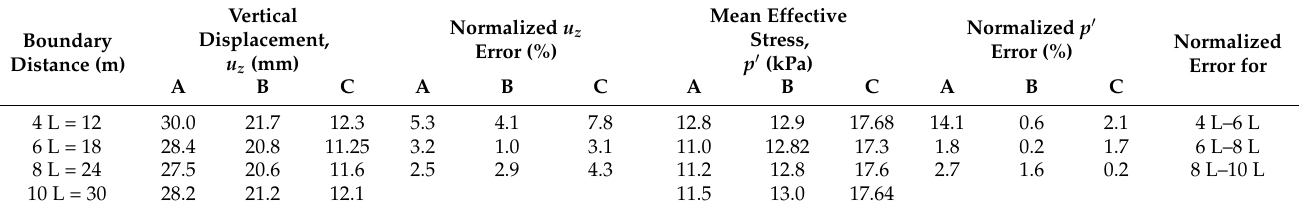
Table 6. Influence of the bottom boundary distance upon footing settlement.